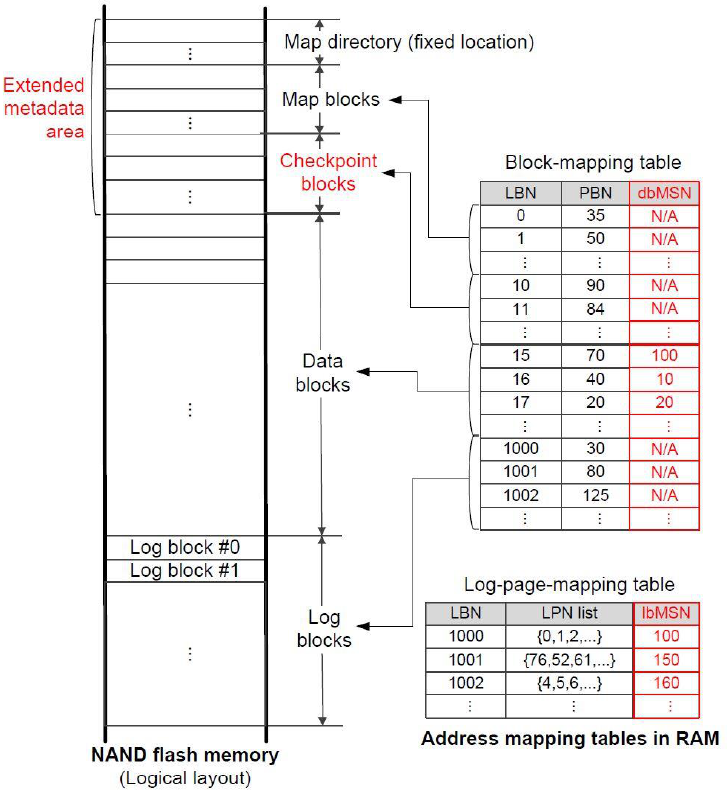
Figure 1. FAST architecture. dbMSN: data block merge sequence number, lbMSN: log block merge sequence number, LBN: logical block number, LPN: logical page number, PBN: physical block number.